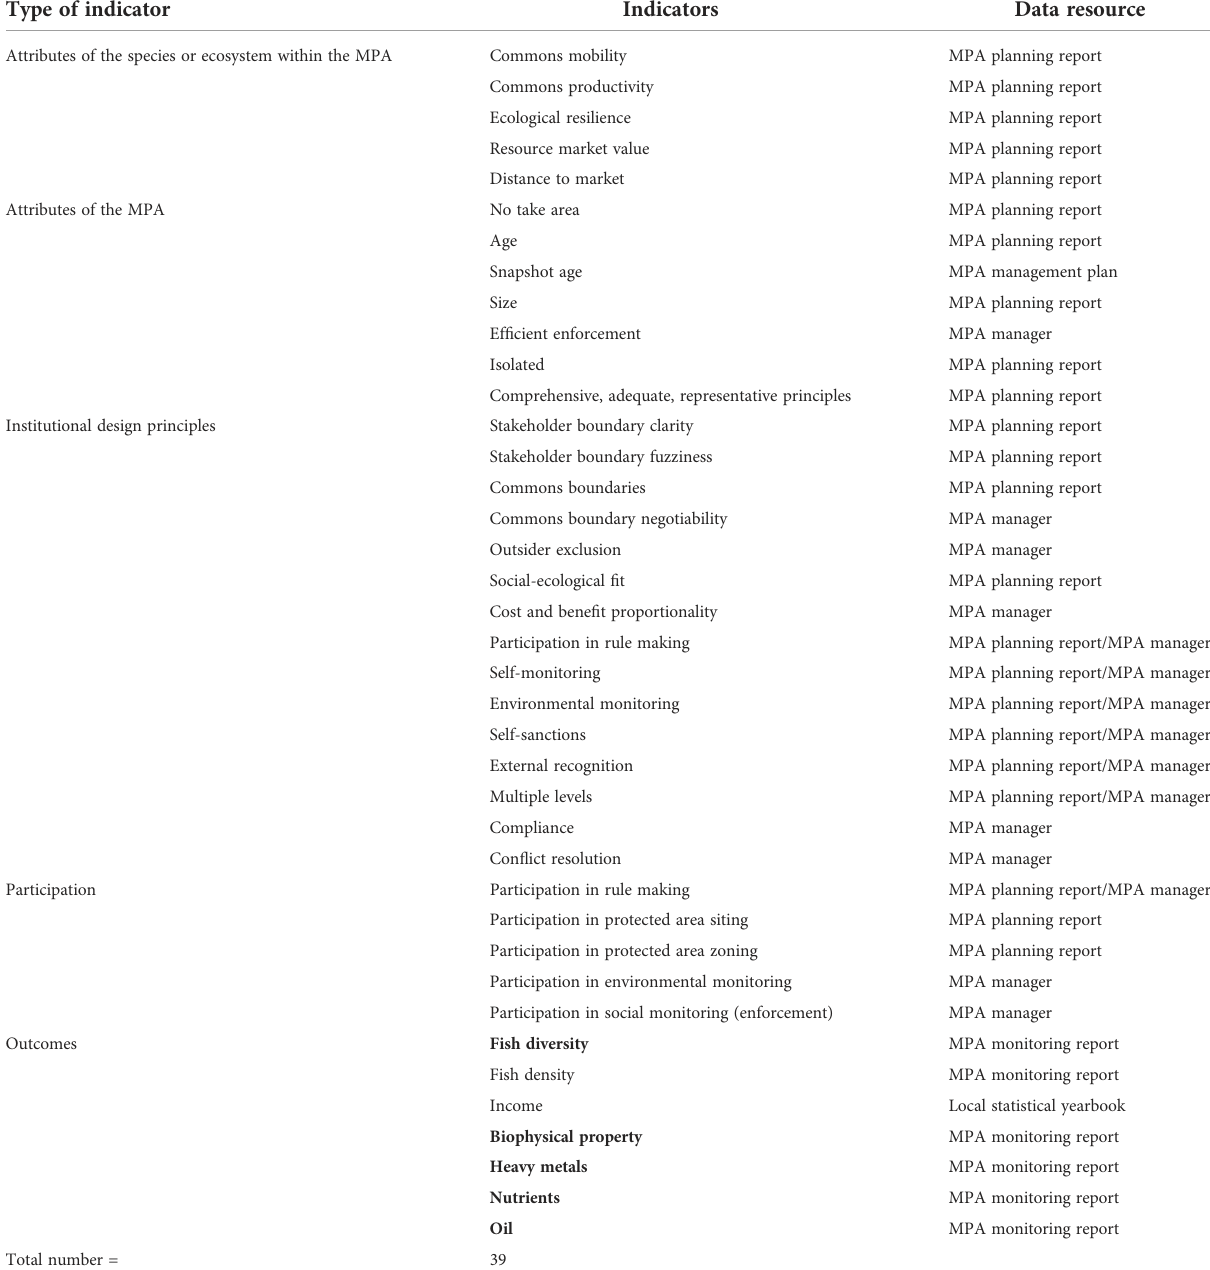
TABLE 1 Evaluation indicators and data resources for assessing Shengsi, Putuo, and Jiushan; bold indicates newly added